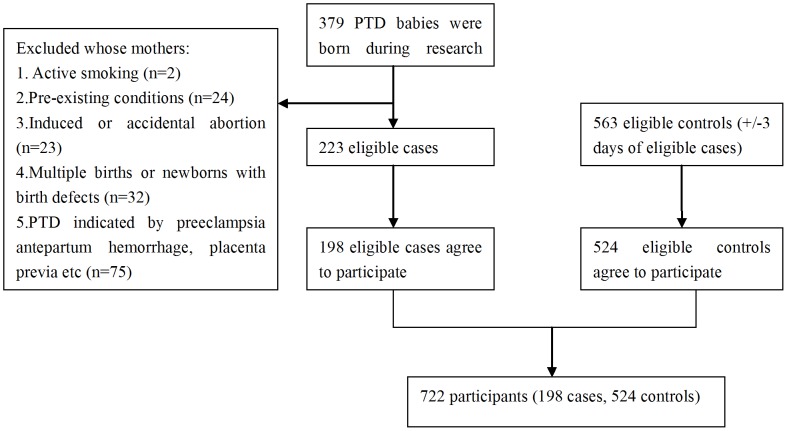
Flow chart of study participants.